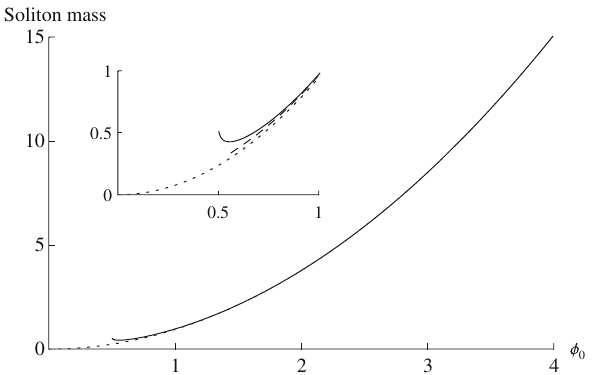
Fig. 8 The classical soliton mass as a function of φ 0 . Solid and dashed curves show the classical soliton mass in the dynamical model cor- responding to positive and negative bound energies, respectively. The dotted line is the classical soliton mass for the background model